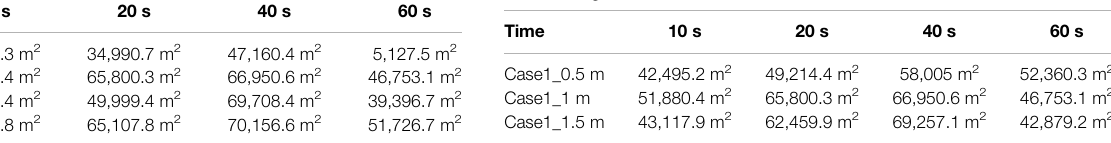
TABLE 5 | CD-4 calculated at different time points of four terrain types. TABLE 6 | Comparison of the CD-4 at different time points with shrubs of three different